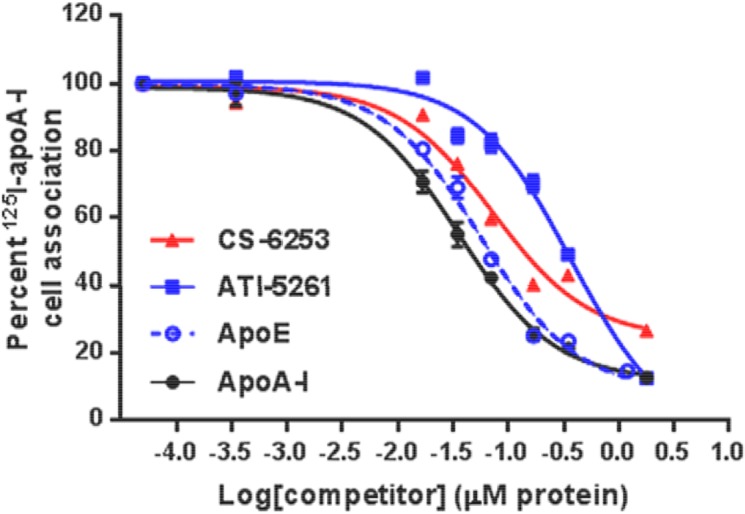
Competitive binding of CS-6253 peptide to ABCA1 cells expressing ABCA1.BHK-ABCA1 cells were plated in 24-well plates and stimulated for 20 h. Cells were then incubated with 2 μg/ml of 125I-apo A-I for 2 h at 37°C with increasing molar concentrations relative to apo A-I of either CS-6253 peptide, ATI-5261, human apo E, and unlabelled apo A-I (0, 0.0035, 0.017, 0.035, 0.071, 0.17, 0.35, 1.79 μM). Cells were then washed rapidly three times with ice-cold PBS/BSA and then PBS alone. 125I-apo A-I cell associated was determined as described under “Experimental Procedures.” The values shown represent the mean ± S.D from triplicate wells. The 100% of control value measured in the absence of competitors was 0.21 ng of apo A-I /μg cell protein. Values of IC50 shown were determined using the Graph Pad Prism 6 software.